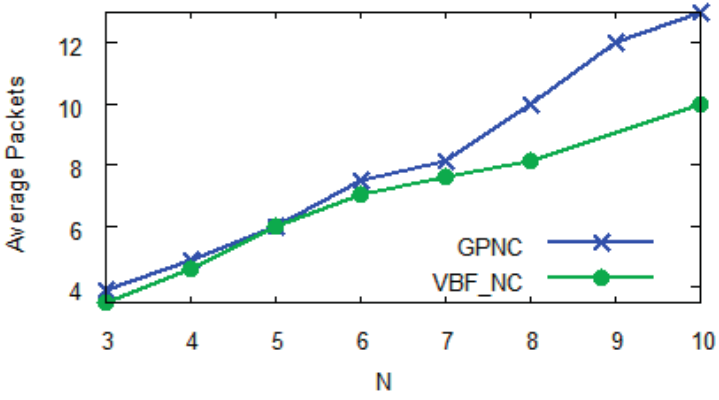
Figure 7. Impact of N on the number of required packets for